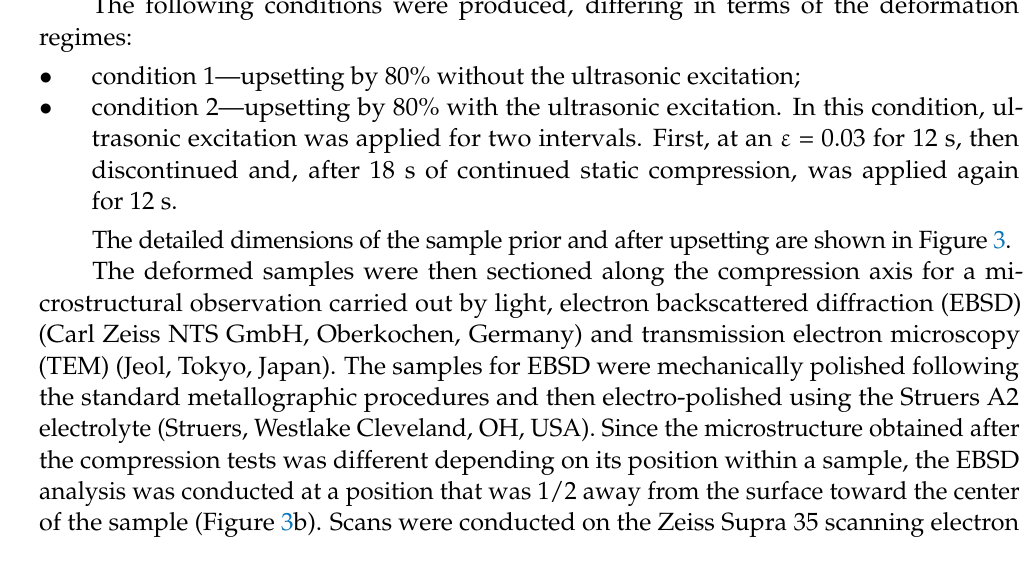
Figure 2. The main components of the experimental setup used in this